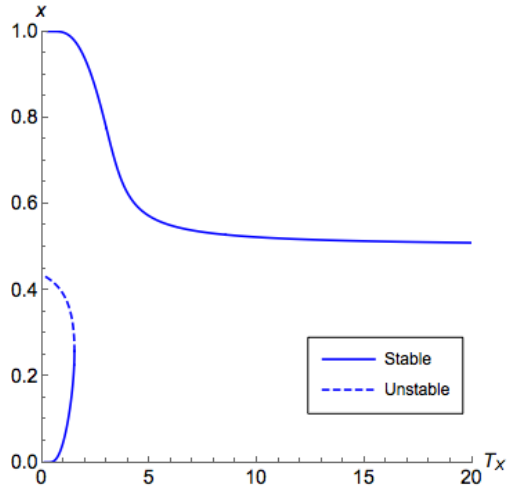
Figure 3. Bifurcation diagram for Example 1 with T y = 2. The horizontal axis corresponds to the temperature T x for the first (row) player and the vertical axis corresponds to the probability that the first player chooses the first action in equilibrium. Similar to Figure 2, there exist three branches (two stable and one unstable). However, unlike Figure 2, now the two branches appearing in pairs happen at x < 0.5, and the principal branch is at x >